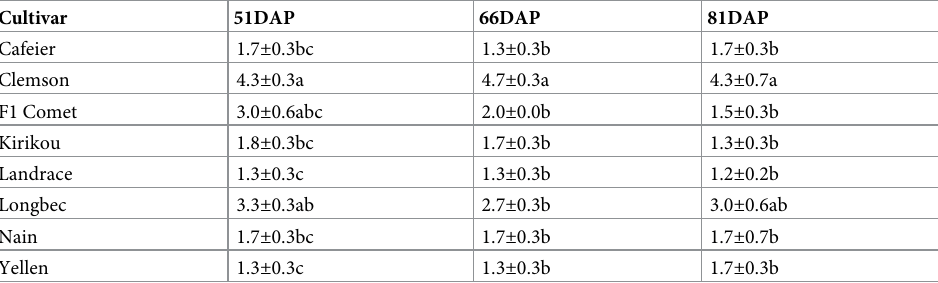
Table 14. Severity of wilt on okra cultivars.